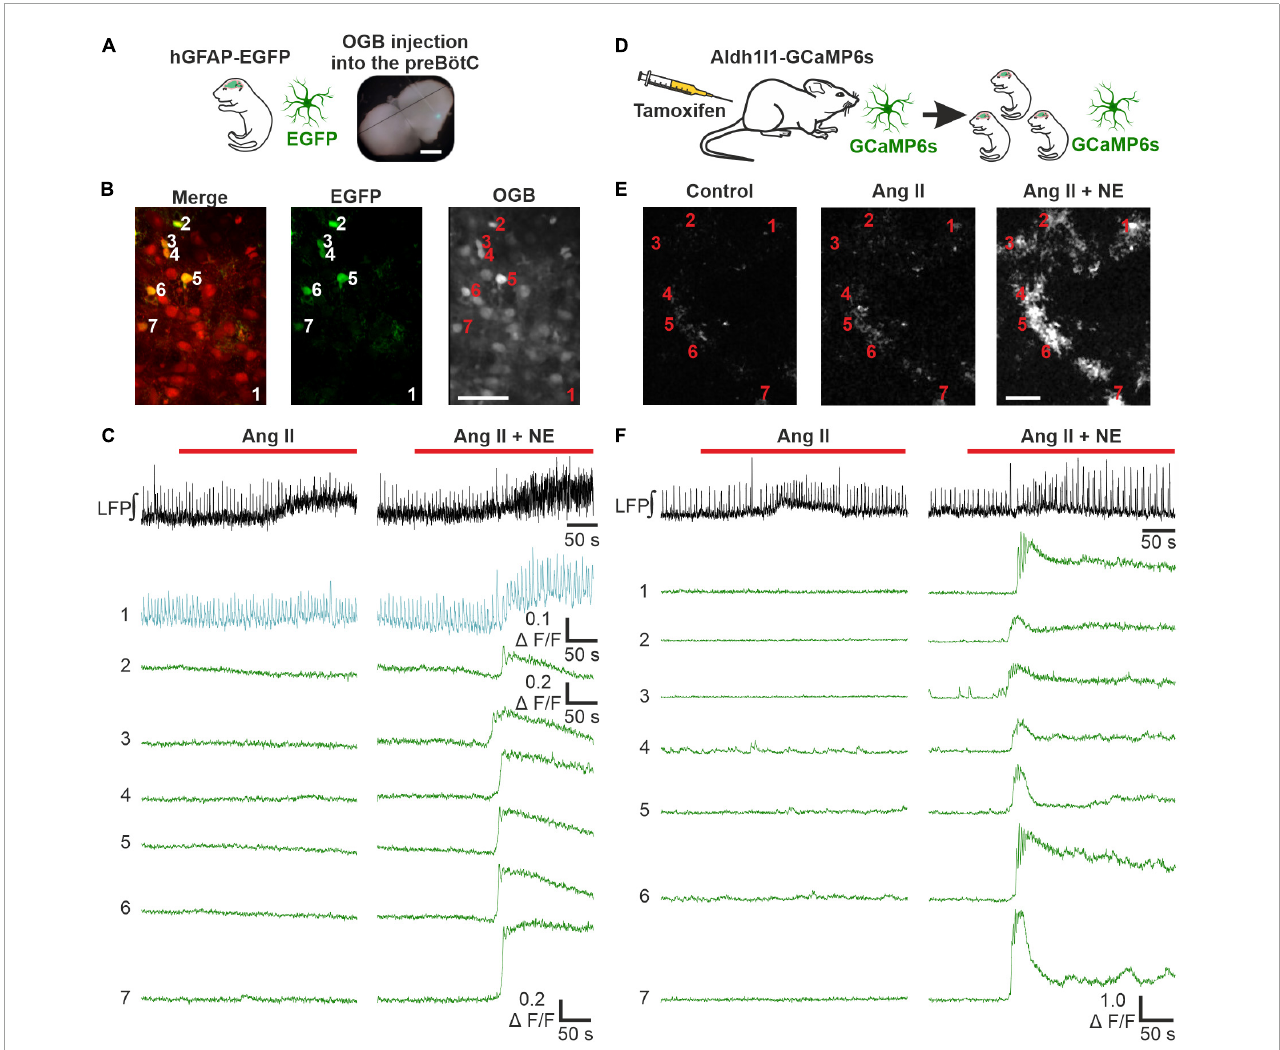
FIGURE6 Ang II does not lead to an increase in intracellular calcium in astrocytes. LFP recordings were combined with 2P microscopy in acute rhythmic slices. Two mouse models were used to investigate the effect of Ang II on astrocytes. (A–C) Acute slices of mice expressing EGFP in astrocytes were injected with OGB. (A) Scale bar 1 mm. (B) Exemplary images for EGFP and OGB. (D–F) Mice expressing GCaMP6s in astrocytes conditionally, were injected with tamoxifen on two consecutive days postpartum. The pups receive tamoxifen through the mother’s milk, allowing direct calcium-imaging of astrocytes. The numbers in the images (B,E) indicate the cells for which the calcium-traces are shown (C,F) . (B,E) Scale bars 50 µ m. (C,F) Co-treatment with norepinephrine (NE) served as a positive control after the Ang II application. (A–C) N = 11 slices, n = 70 astrocytes and (D–F) N = 9 slices, n = 160